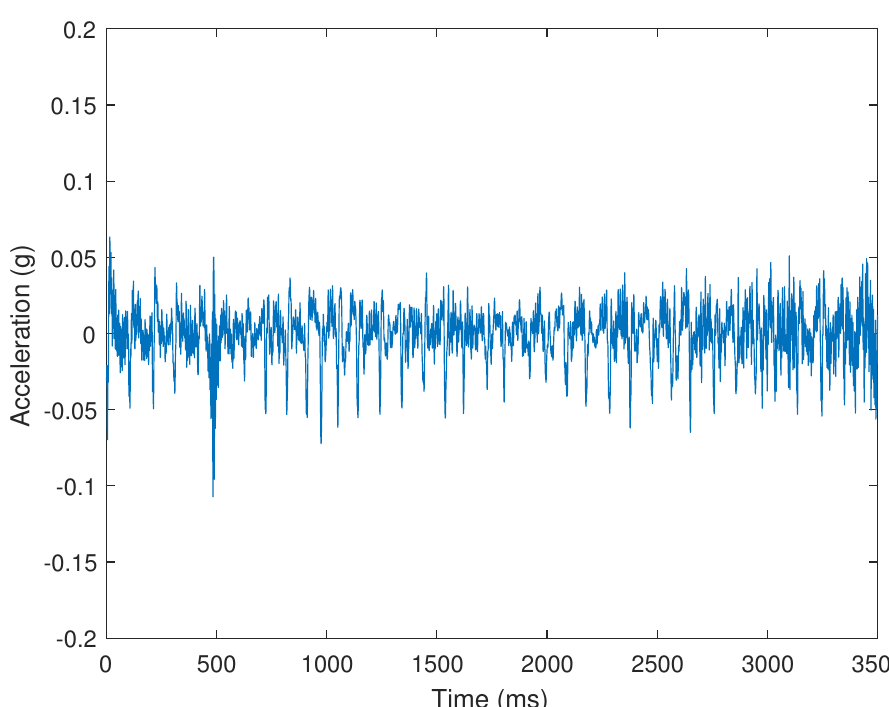
Figure 4. Right side acceleration of the Parkinson’s disease (PD) patient.